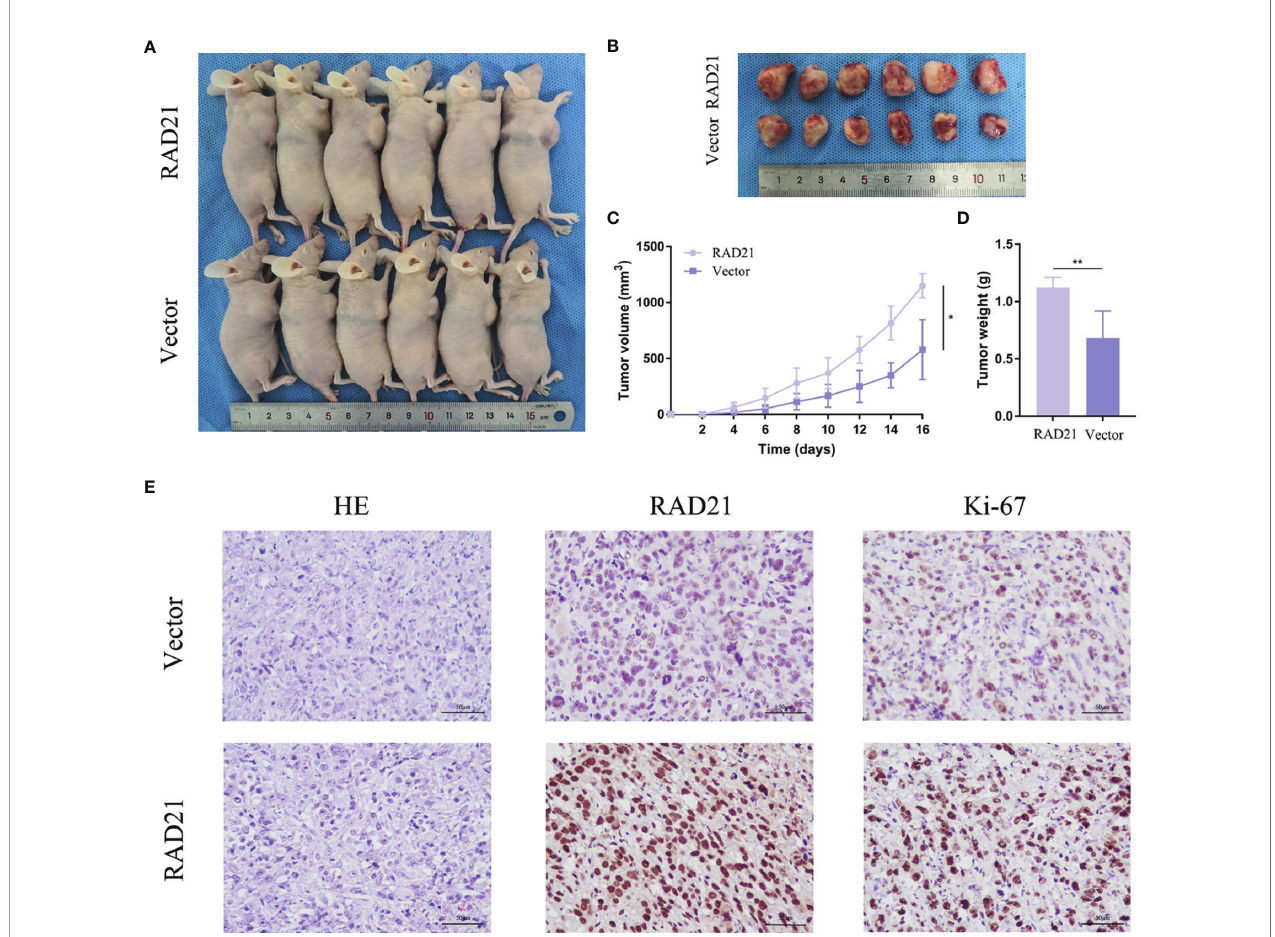
FIGURE 6 | The impact of RAD21 on tumor formation in vivo . (A) Subcutaneous xenograft nude mouse model. (B) Images of tumors from nude mice in the vector and RAD21-overexpressing groups. (C) Subcutaneous tumor volume in the two groups. (D) Tumor weight in the two groups. (E) H&E and immunohistochemical staining in the two groups. * p < 0.05; ** p <